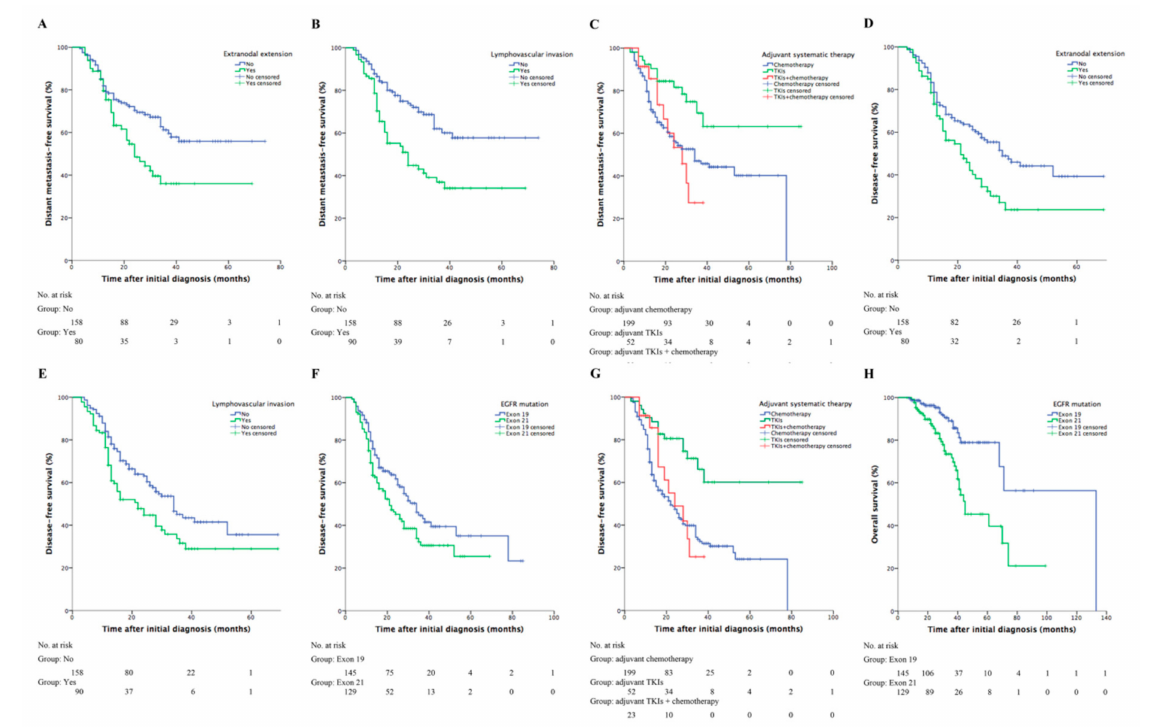
Figure 2. Clinical outcomes based on different prognostic factors. The DMFS curves for patients sub-grouped by ( A ) pathologic extranodal extension (two-year DMFS, yes vs. no, 48.5% vs. 70.4%, p = 0.005), ( B ) lymphovascular invasion (44.8% vs. 74.0%, yes vs. no, p < 0.001), and ( C ) system adjuvant therapy (adjuvant TKIs vs. adjuvant TKIs+chemotherapy vs. adjuvant chemotherapy, 81.5% vs. 53.4% vs. 56.4%, p = 0.006). The DFS curves for patients sub-grouped by ( D ) pathologic extranodal extension (two-year DFS, yes vs. no, 42.1% vs. 62.9%, p = 0.004), ( E ) lympovascular invasion (yes vs. no, 44.7% vs. 63.0%, p = 0.013), ( F ) EGFR mutations (exon 19 vs. 21, 61.8% vs. 45.2%, p = 0.025), and ( G ) systemic adjuvant therapy (adjuvant TKIs vs. adjuvant TKIs+chemotherapy vs. adjuvant chemotherapy, 80.6% vs. 48.9% vs. 47.4%, p < 0.001). ( H ) The OS curve for patients with EGFR exon 19 or 21 mutation (two-year OS, exon 19 vs. 21, 96.2% vs. 85.5%, p < 0.001). DMFS: distant metastasis-free survival; TKIs: tyrosine-kinase inhibitors; DFS: disease-free survival; EGFR : epidermal growth factor receptor; OS: overall